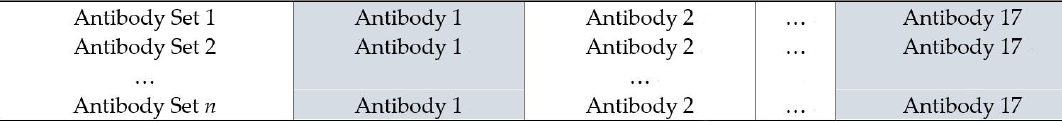
Figure 8. Allocation of antibodies for the transition functions of an FSM (an antibody set presents an FSM; a population will evolve to select a best antibody